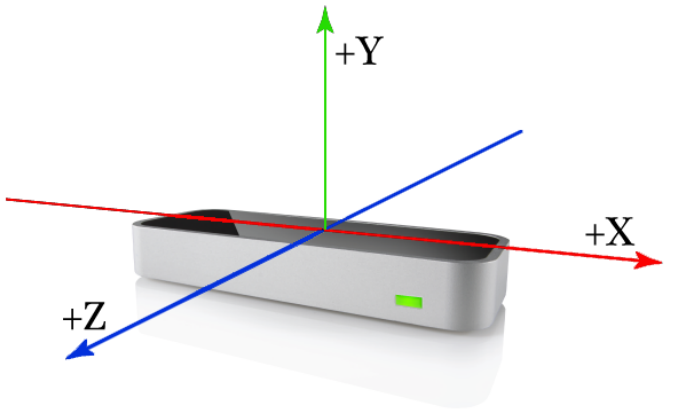
Figure 2. The LMC X-Y-X orientation. When the right hand moves away to the right, its x value increases. When the left hand moves away to the left, its x value decreases. The Y-axis is associated with the hand’s height relative to the sensor (there is no negative height). The Z-axis is associated with depth. For example, in Figure 1, when the hand approaches the screen, the Z value decreases. between those attitudes.